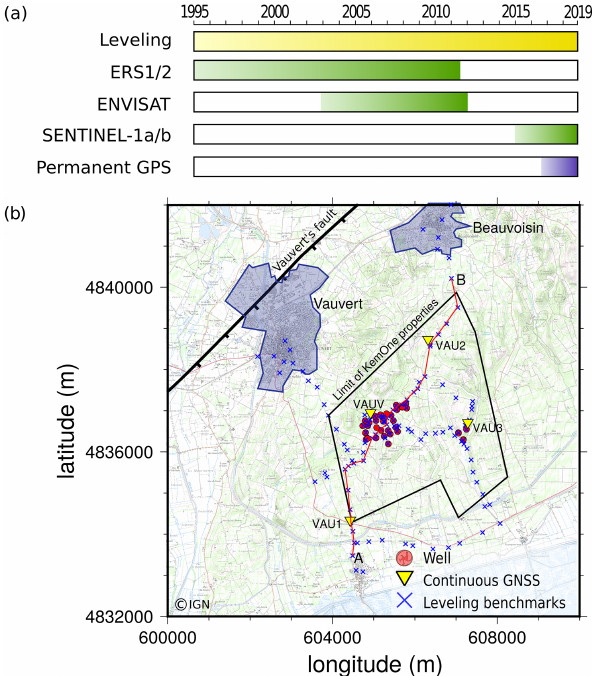
Figure 2. (a) Temporal coverage of geodetic networks monitoring the site. (b) Spatial coverage of GNSS and leveling network of the salt exploitation in Vauvert. Well heads are represented by red cir- cles, permanent GNSS is represented by yellow inverted triangles, and leveling benchmarks are identified by blue crosses. The red line indicates the profile A–B for leveling data represented in Fig. 3a. The blue areas represent the extent of Vauvert and Beauvoisin cities, while the black line defines the extent of the KemOne company. The background map is extracted from IGN SCAN 1 : 25000 (©